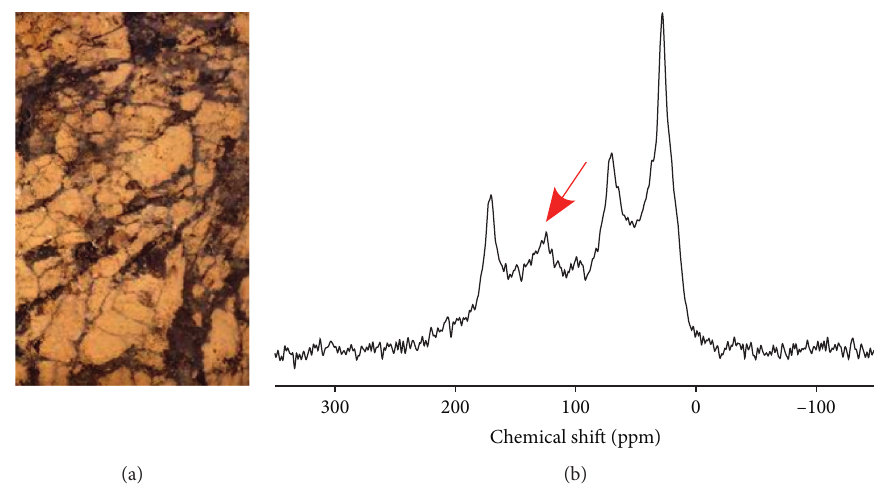
Figure 7: (a) Organic matter/clay coatings on blocky peds in the subsoil (the Bhs horizon) of the Podzol in sandy colluvium under rainforest at Eleven Road. Vertical section, 10cm from top to bottom. (b) NMR spectrum for the organic matter/clay coatings; from right to left, the four peaks represent alkyl-C (0–50 ppm), O-alkyl-C (50–110ppm), aryl-C (110–145ppm; arrowed), and O-aryl-C